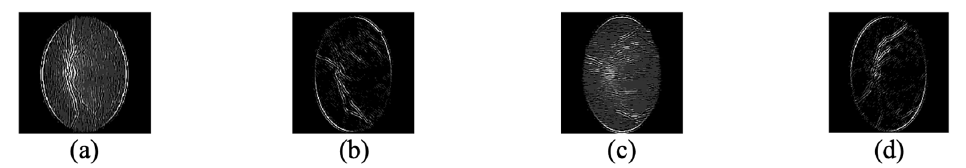
Figure 3. Four Gabor filters used in this research: ( a ) 90’, ( b ) 45’, ( c ) 0’, and ( d ) − 45’. Using